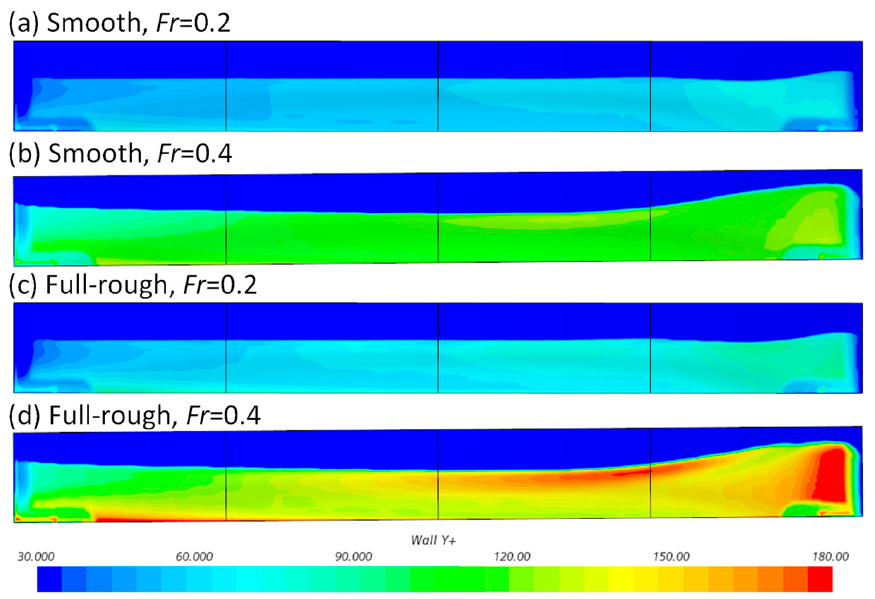
Figure 6. Wall y + on the Wigley hull.